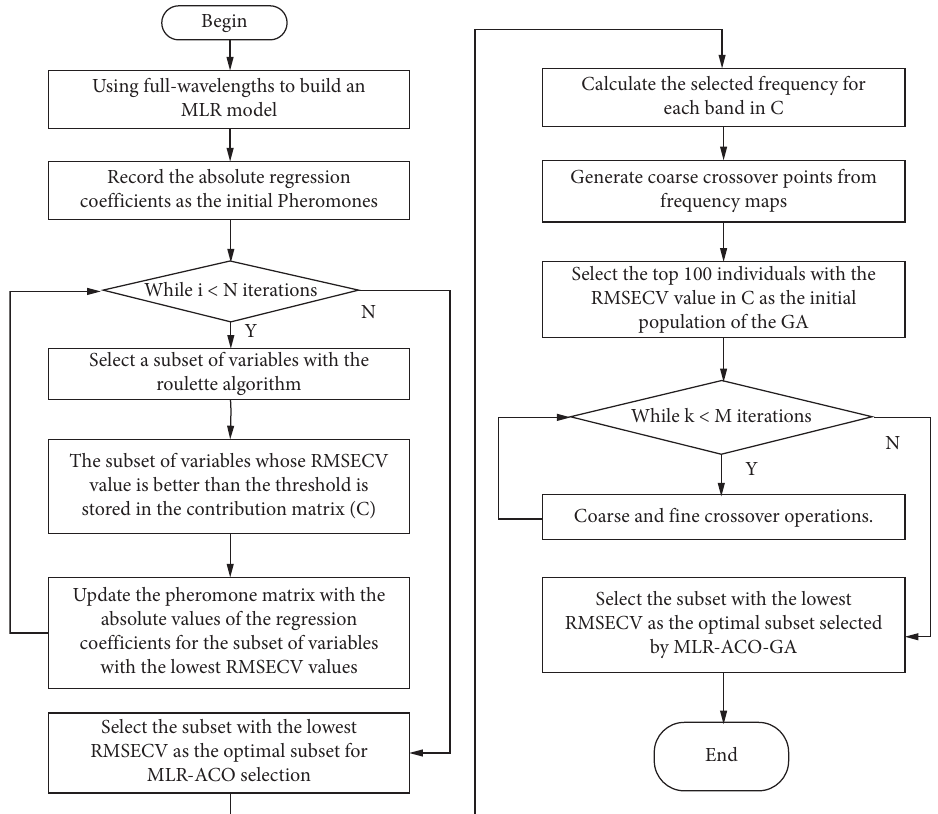
Figure 1: Flow chart of MLR-ACO-GA